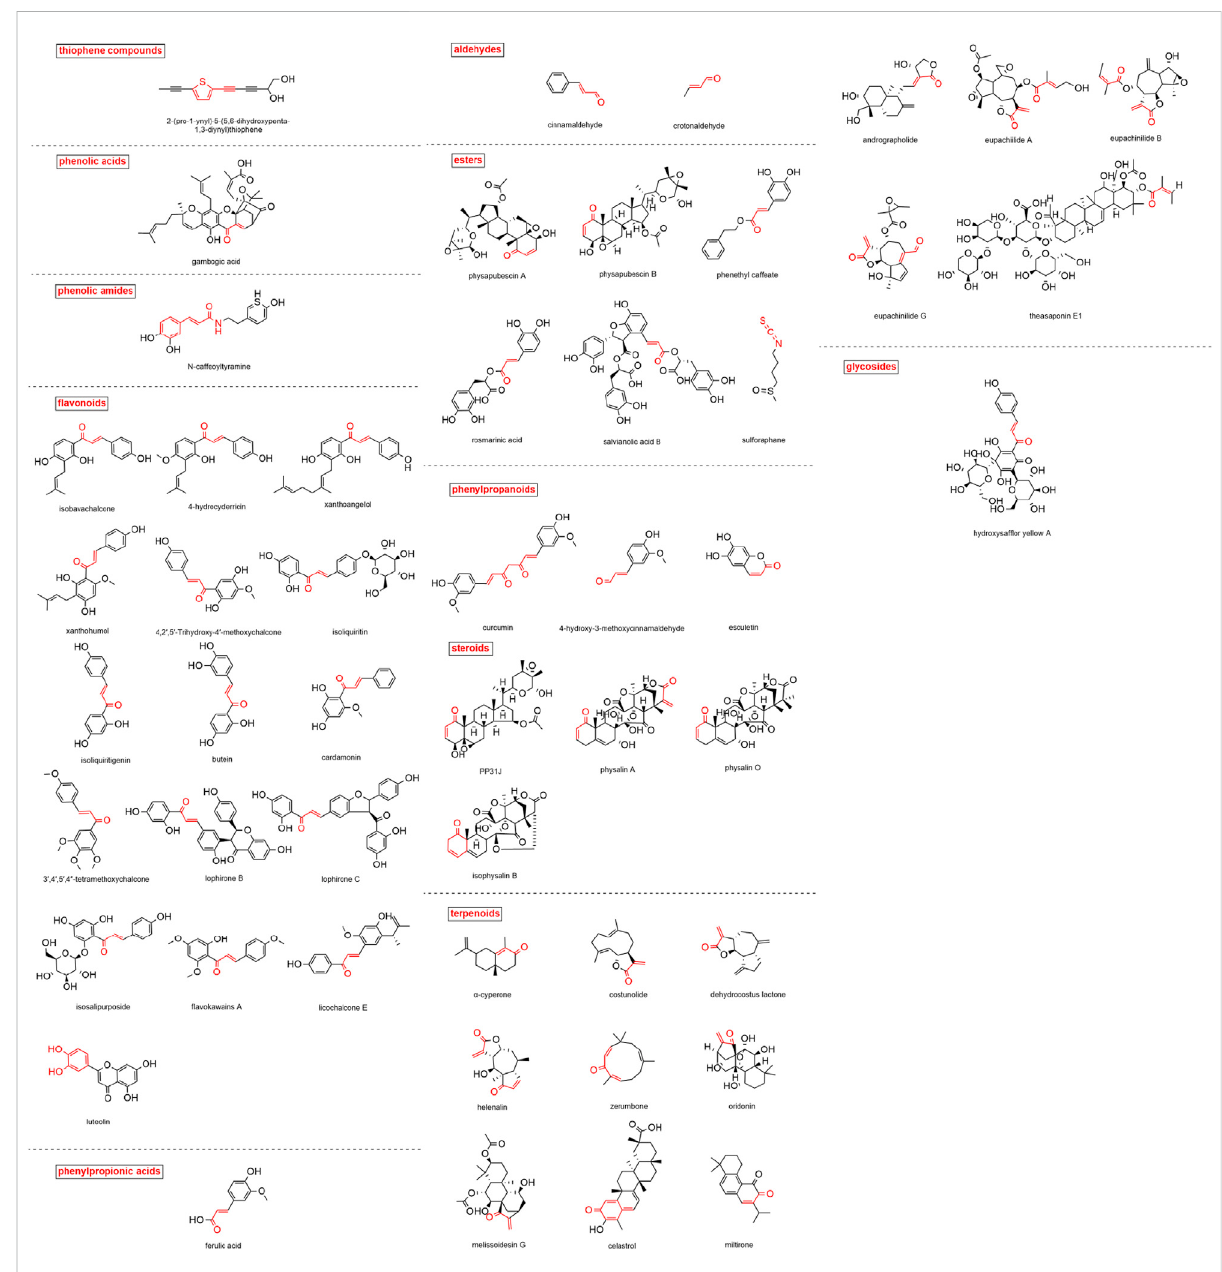
FIGURE 3 Structure of natural MAMs (Michael reaction active sites are indicated in